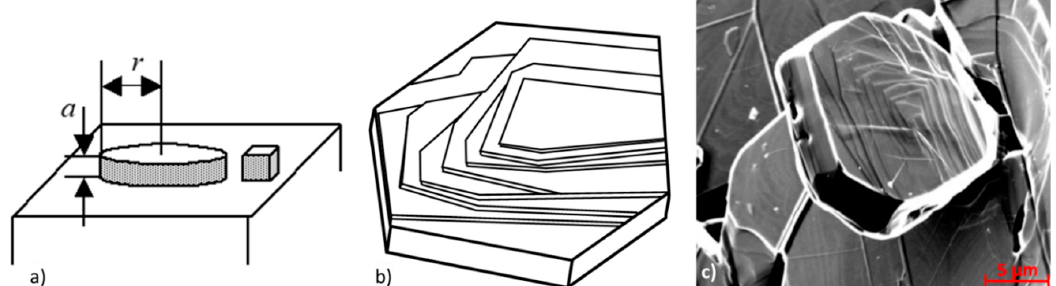
Figure 7. Two-dimensional nucleation: ( a ) Schematic representation of 2-D nucleation; ( b ) schematic representation of sequential poly-nucleation growth of graphite nucleus; ( c ) thick polyhedral graphite plate in Ni-C alloy proving PNG and migration of ledges, reproduced from [31] with permission from Elsevier.